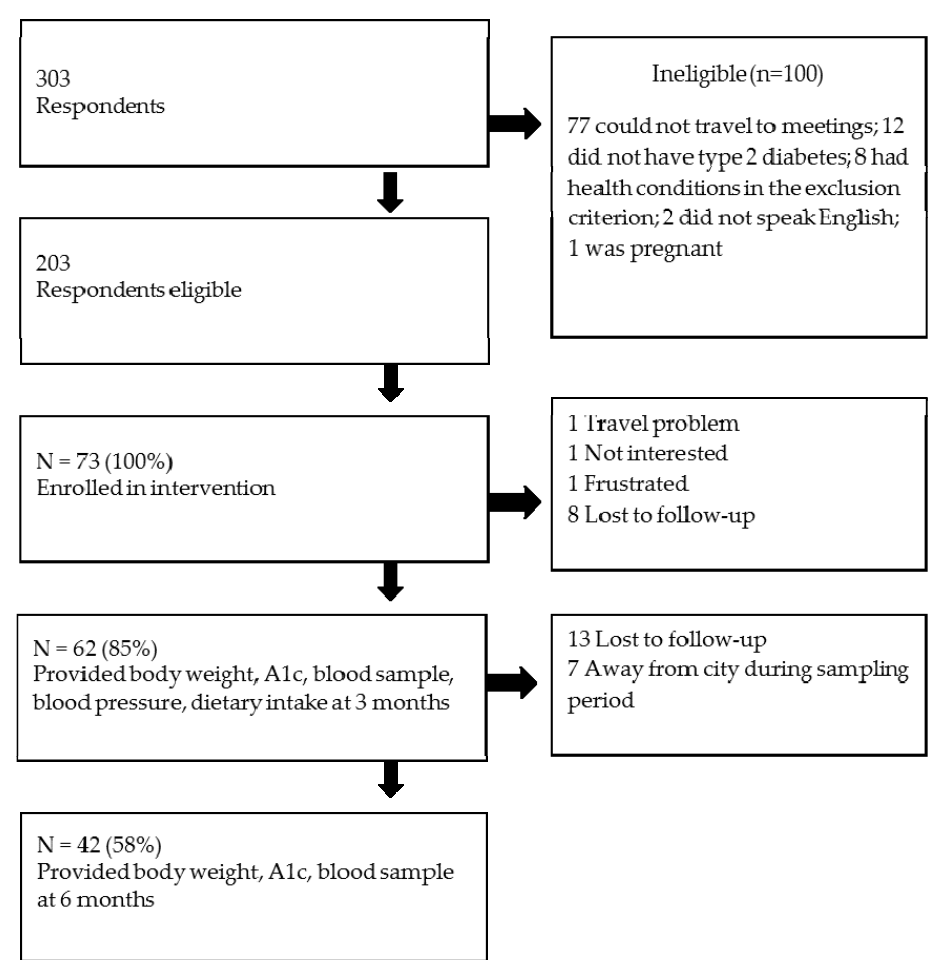
Figure 1. Participant recruitment and retention flow chart.